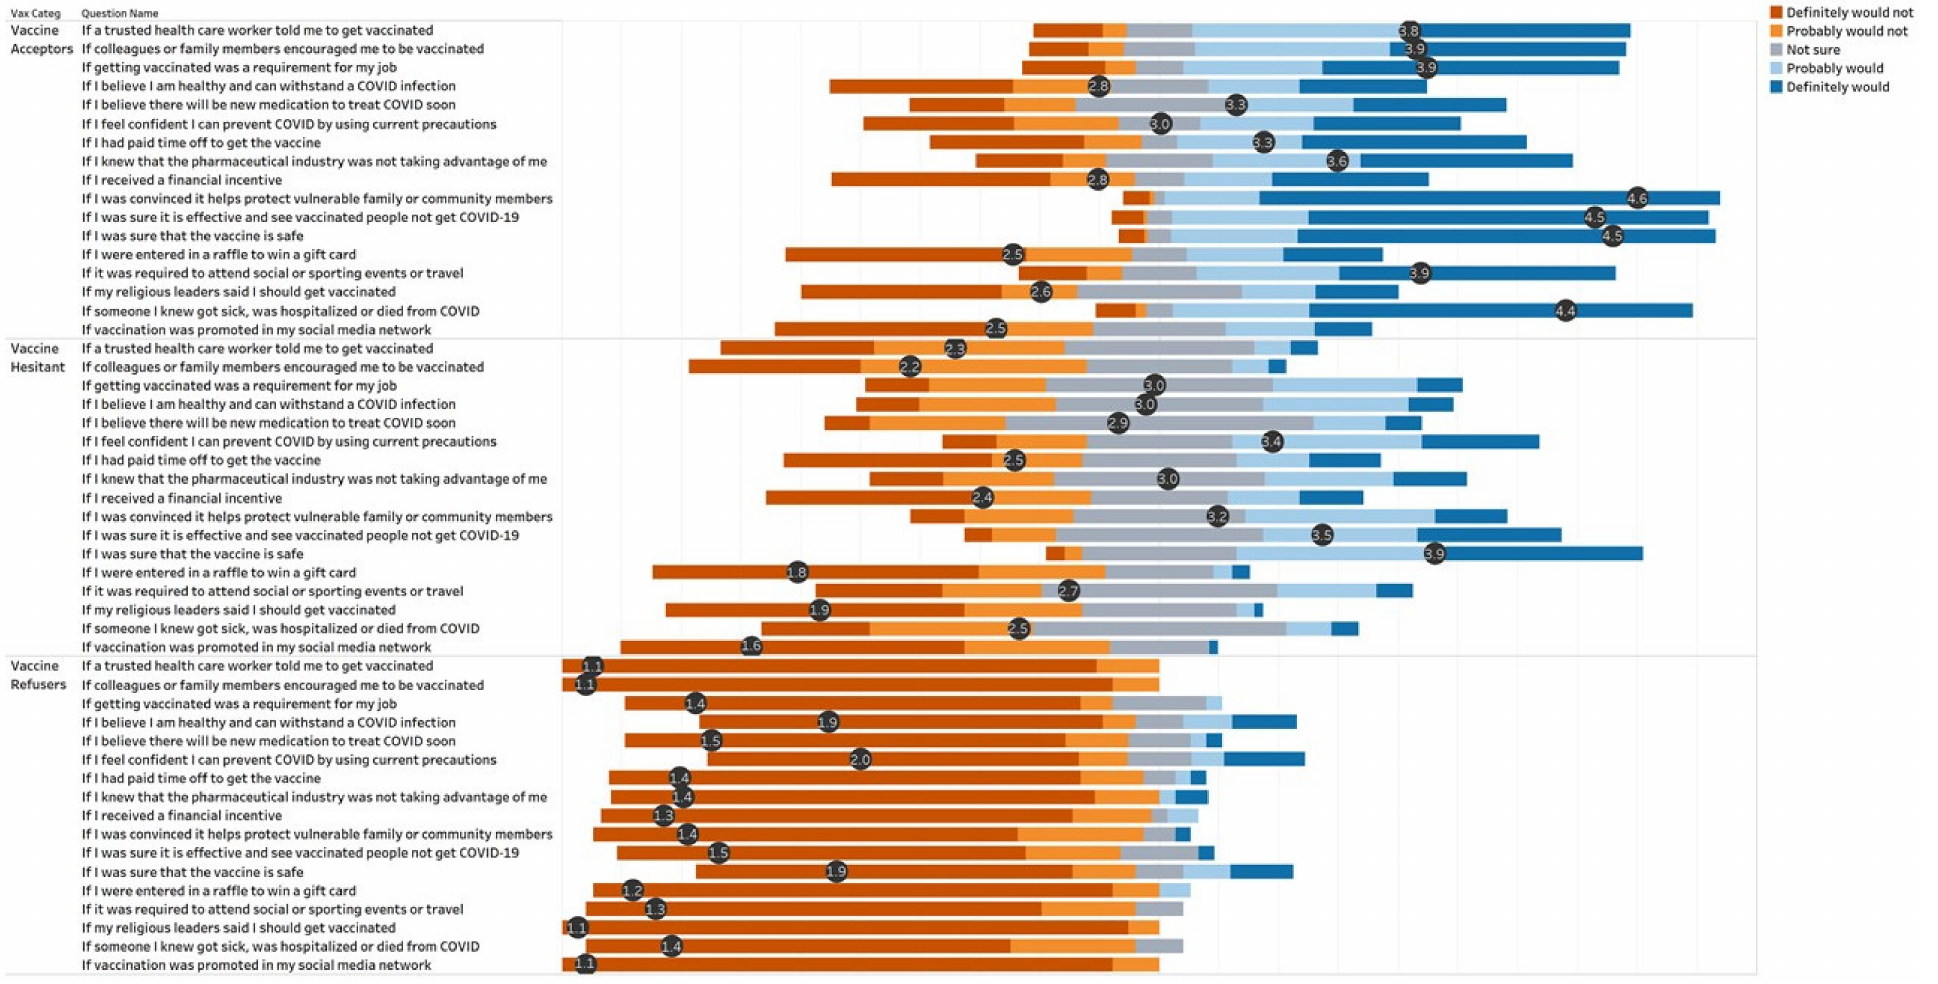
Figure 1. Influences of Decision for COVID-19 Vaccination with Average Score on Likert Scale for Each Response, by